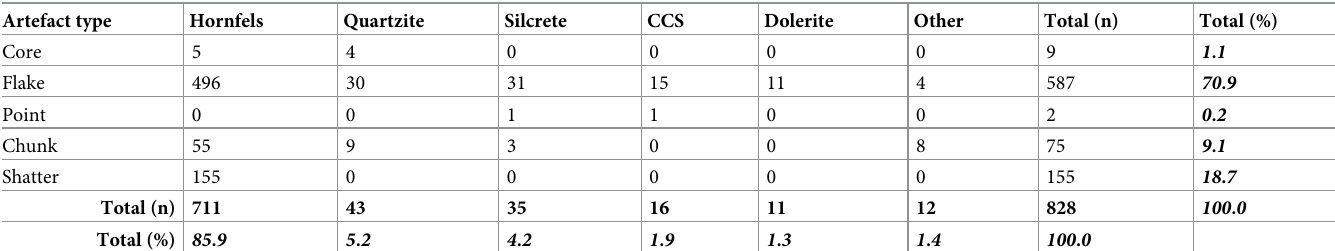
Table 2. Artefact frequencies recorded in complete grid squares 18/-1, 18/+1, 18/+2, sampling all artefacts > 10mm, in all raw materials. Artefact type